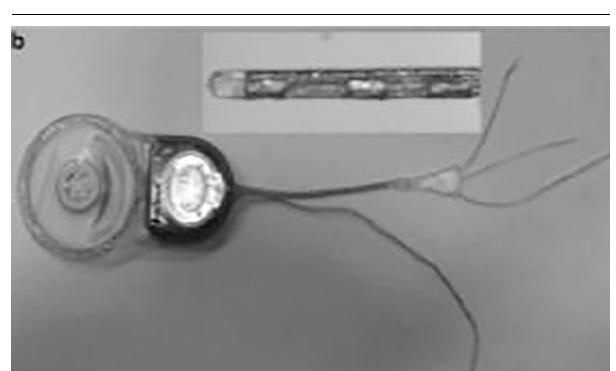
electrodes total) (quoted from Rubinstein and